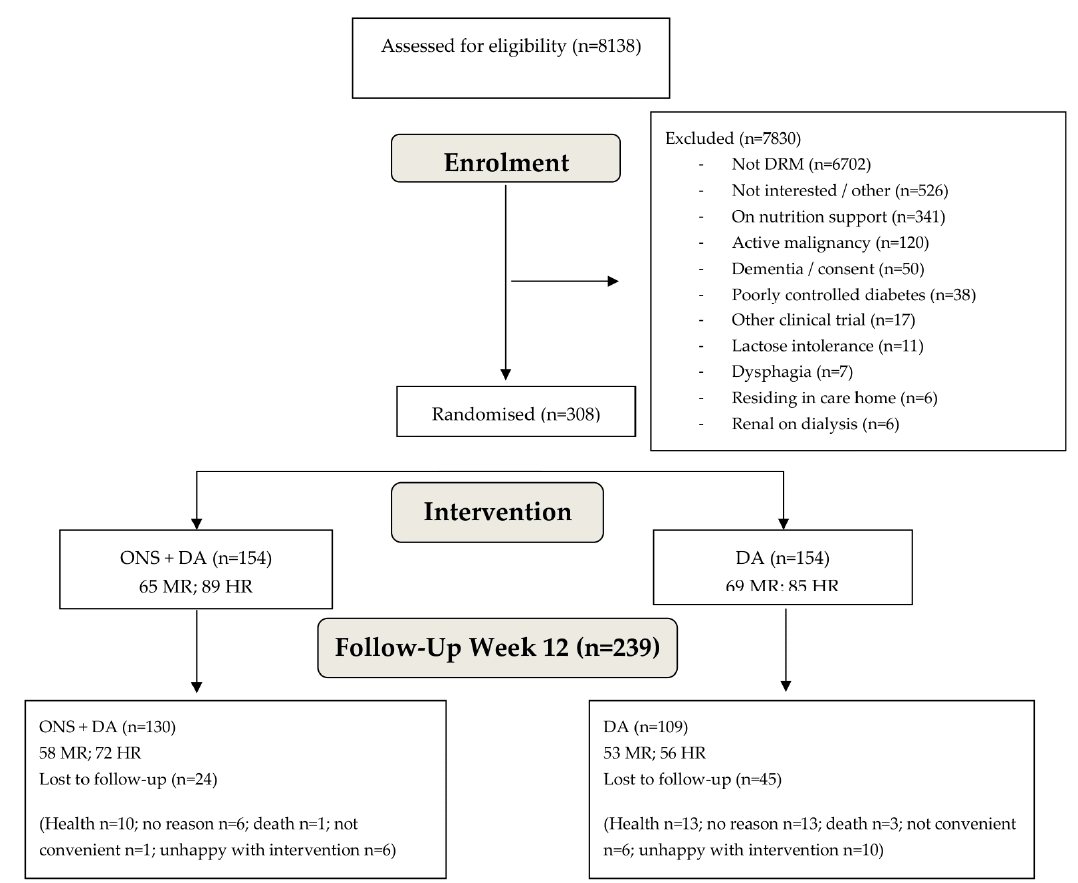
Figure 1. Flow diagram of participants from screening to week 12 follow up visit. ONS, oral nutritional supplement. DA, dietary advice. MR, medium risk. HR, high risk.